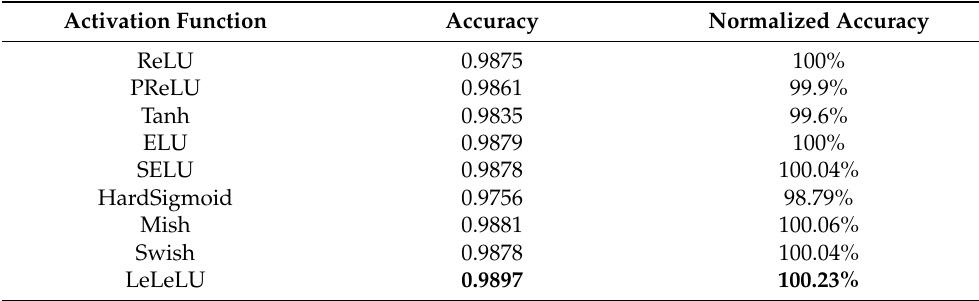
Table 1. Test accuracy in the MNIST dataset of the activation functions in question, using the corresponding neural network, and accuracy normalized to that attained by ReLU activation function.